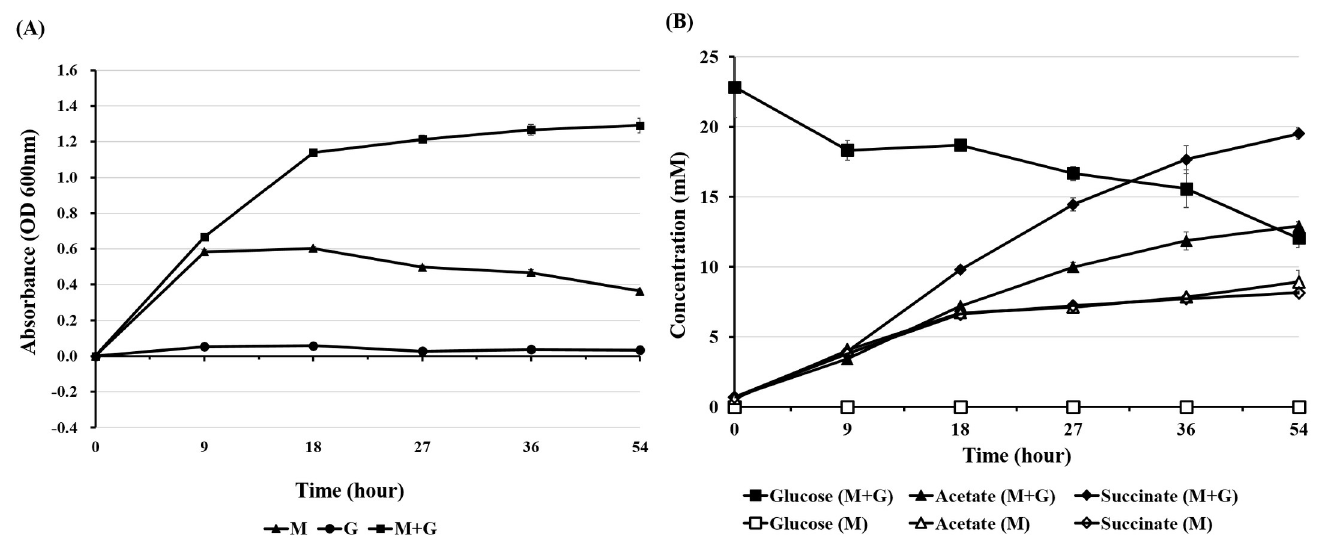
Fig 3. Growth of strain E39 T in the basal mucin (M), glucose (G), and mucin-glucose (M+G) media (A) and profiles of glucose, acetate, and succinate in the basal (M) and mucin-glucose (M+G) media during fermentation (B). Data are presented as mean ± standard error from